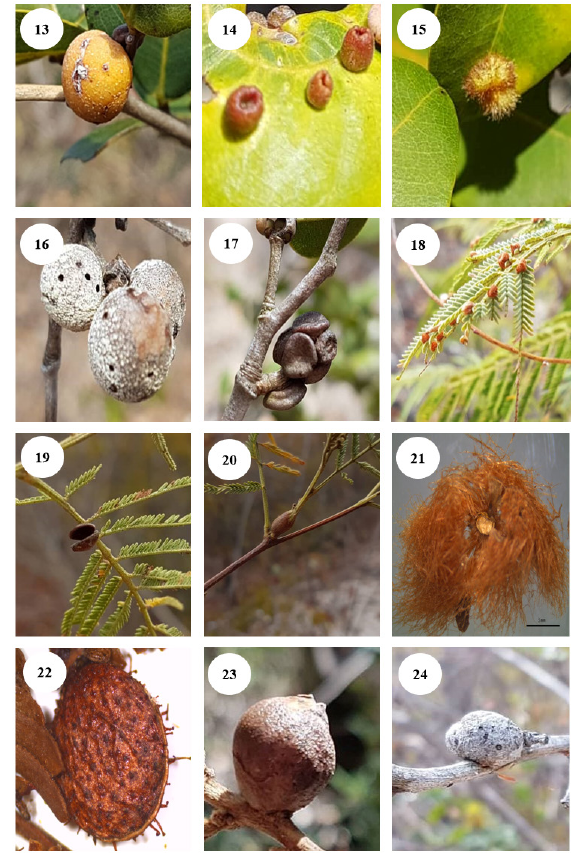
Figure 2. Insect galls associated on Fabaceae occurring in Brazil. 13-14, Copaifera langsdorffii Desf., 15-17, Copaifera sabulicola J.A.S. Costa & L.P. Queiroz., 18-21, Mimosa gemmulata Barneby, 22, Mimosa tenuiflora (Willd.) Poir., 23, Senegalia sp., 24 , Senegalia langsdorffi (Benth.) Seigler & Ebinger. Images: Tainar Araújo (13-20; 23-24) and Juliana Santos